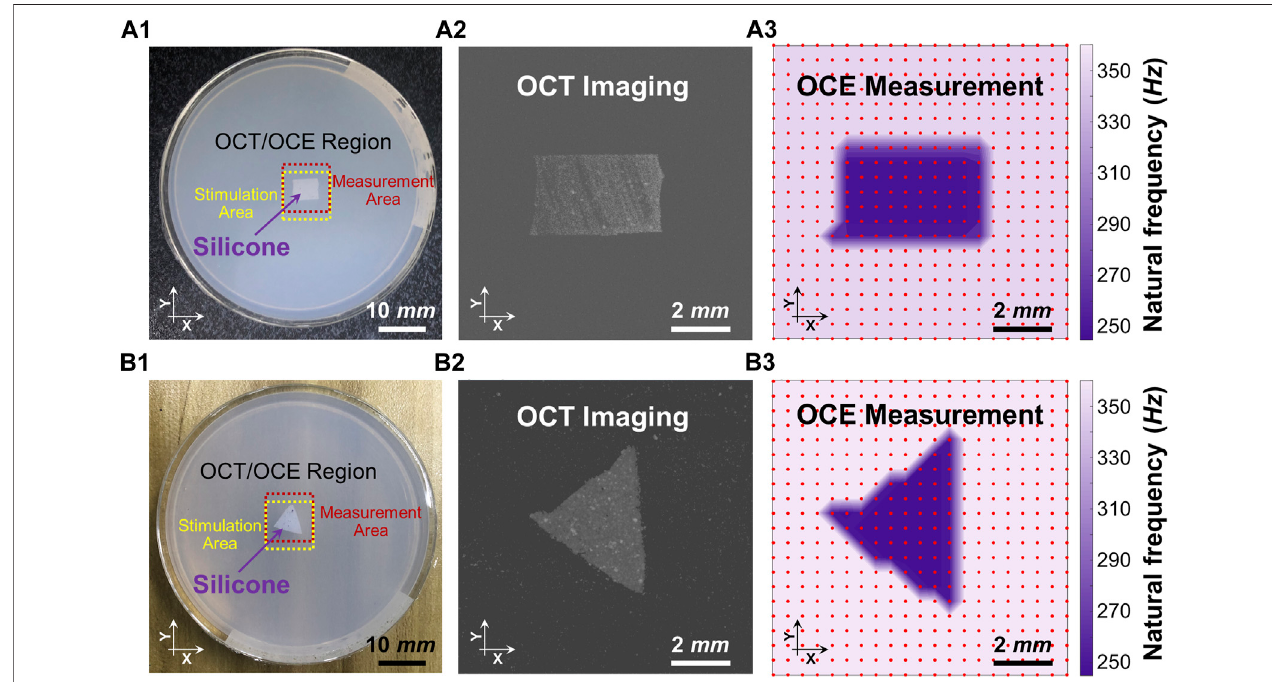
FIGURE 4 | Distinguishing the embedded silicone blocks from the 2% agar using the spatialized dominant natural frequency measurement ( f n ). Panels (A1) and (B1) show the topviews ofthesilicone-agarmixture phantomsand thepositionsofthe stimulation and measurement.Panels (A2) and (B2) arethe enface OCTimages of the rectangular and triangular silicone blocks, respectively. Panels (A3) and (B3) shows spatial distribution of the dominant natural frequencies ( f n ) using the single degreeoffreedommethod.InPanel (A3) ,thedominantnaturalfrequencies(mean±SD)were255.1±11.0 Hzforthesiliconeblockand355.5±1.4 Hzfortheagar basis. In Panel (B3) , the dominant natural frequencies (mean ± SD) were 249.0 ± 4.6 Hz for the silicone block and 361.3 ± 5.5 Hz for the agar basis. Optical coherence tomography (OCT); optical coherence elastography